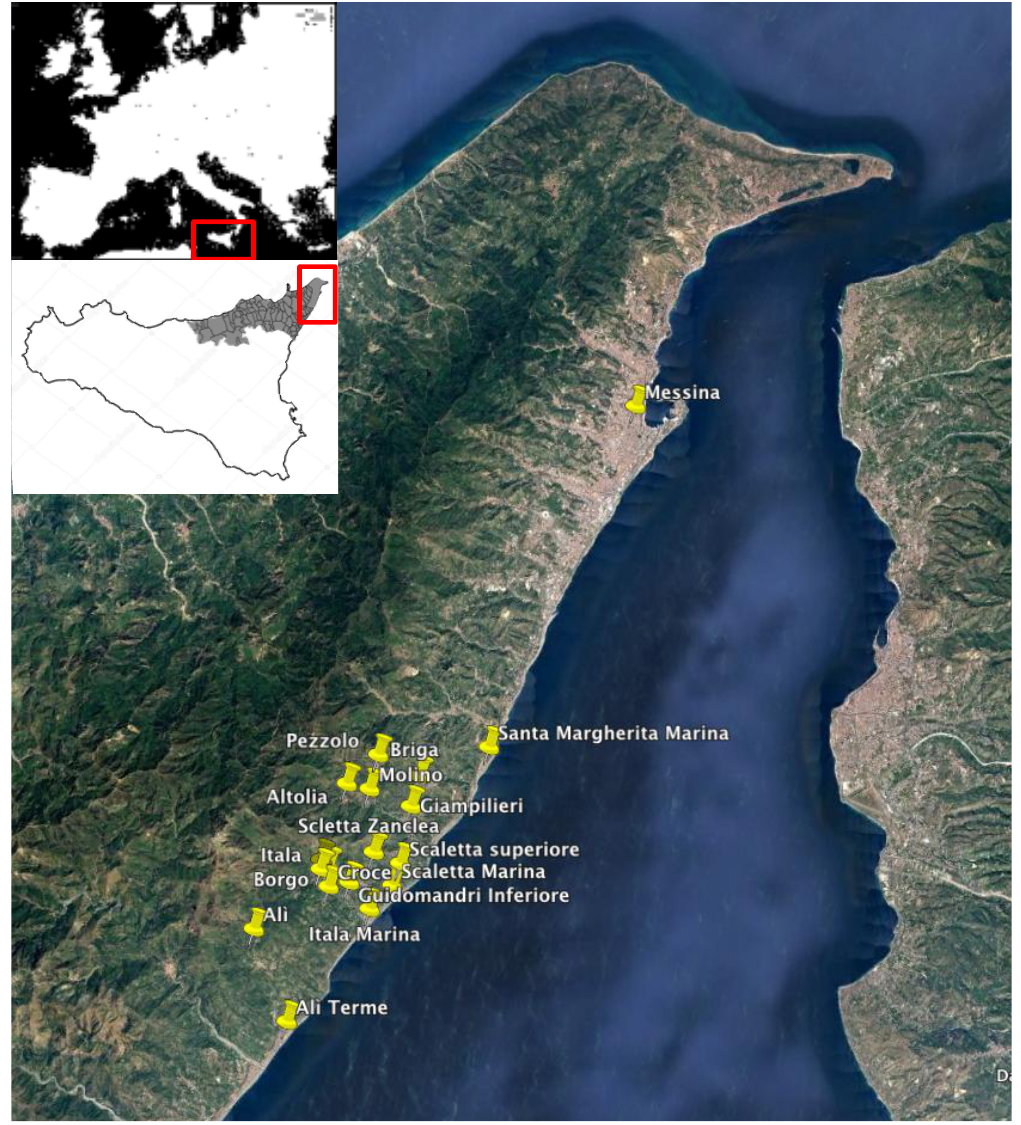
Figure 1. Territorial frame and identification of the main urban centres hit by the flood.